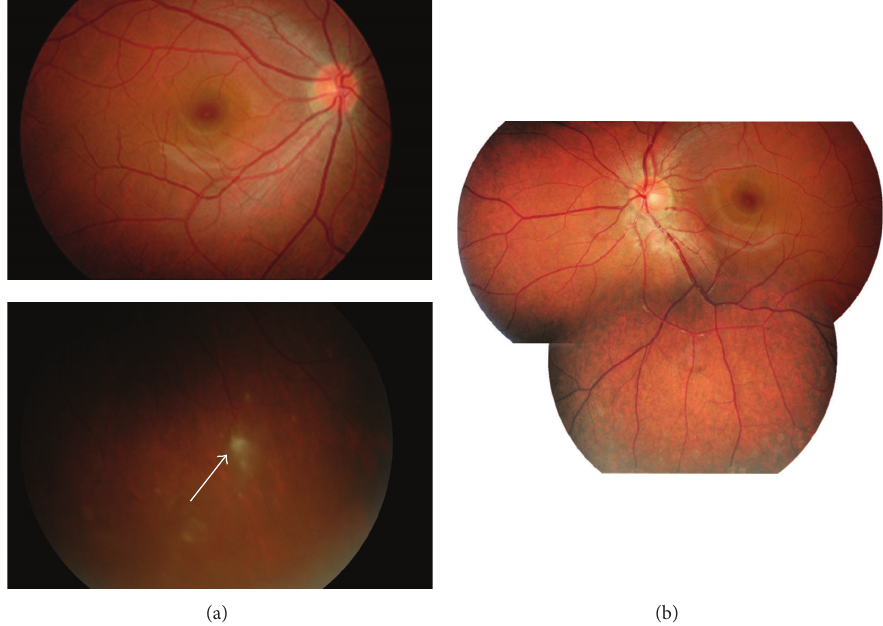
Figure 5: Follow-up fundus photographs taken at 3 months after treatment. Note sharp disc margin and subsiding vitreous and chorioretinal inflammation in both eyes. (a) Right eye. Thin transparent membrane covered the subsiding chorioretinal lesion (white arrow). (b) Left